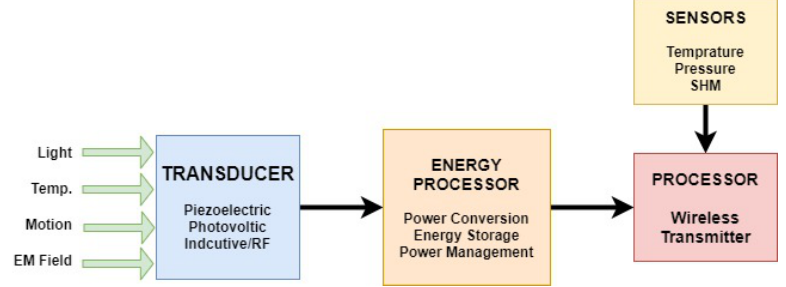
Figure 1. A workflow of energy harvesting.